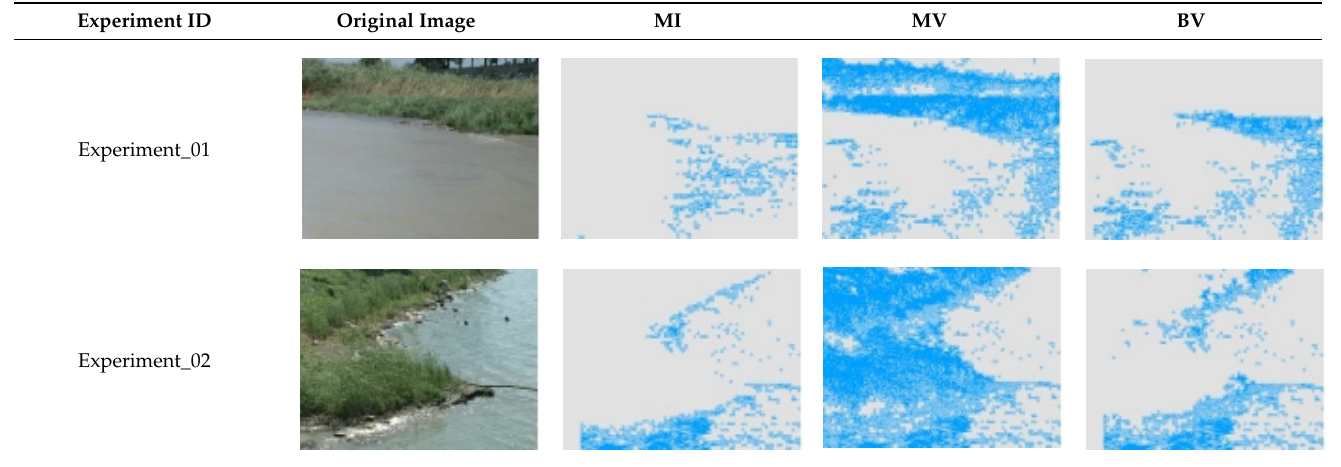
Table 3. The comparison results of algal-bloom recognition in algal areas. (MI is the result of manual interpretation; MV is the recognition result using the method described in [31]; BV is the recognition result of the proposed method; and DV is the errors of PA between the method described in [31] and the proposed method). Experiment ID